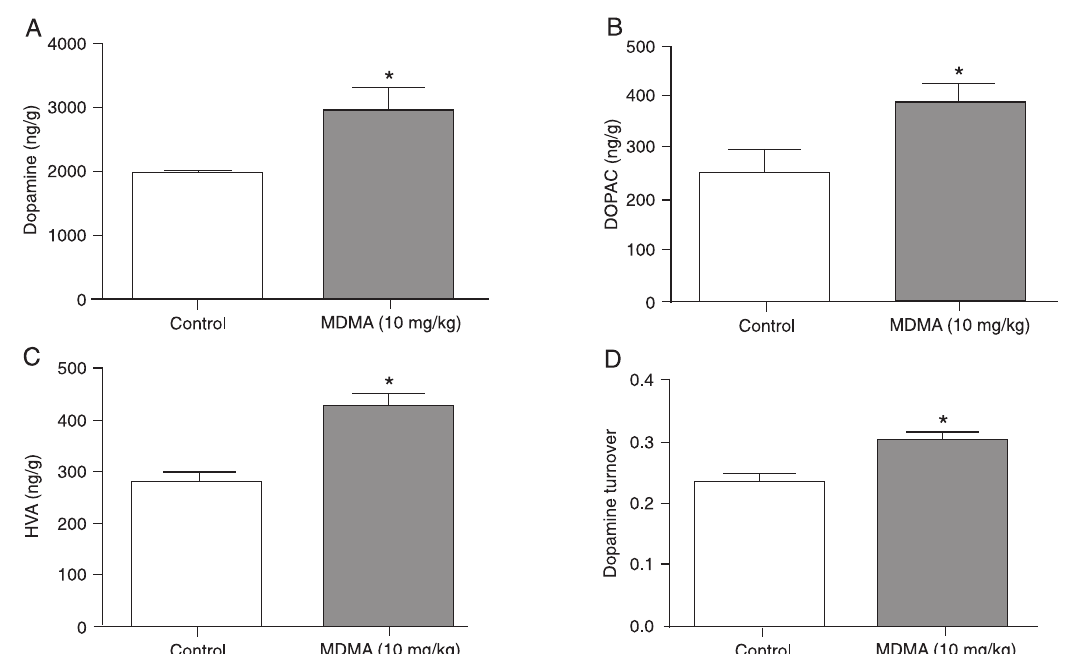
Figure 4. Effects of 3,4-methylenedioxymethamphetamine (MDMA) on the striatal content and turnover of dopamine and its metabolites on BALB/c male mice. A , Dopamine; B , dihydroxyphenylacetic acid (DOPAC); C , homovanillic acid (HVA); D , dopamine turnover (DOPAC+HVA/DA). Data are reported as means ± SEM for 9-10 animals/group. *P < 0.05 compared to control (Student t -test or Mann-Whitney U-test).